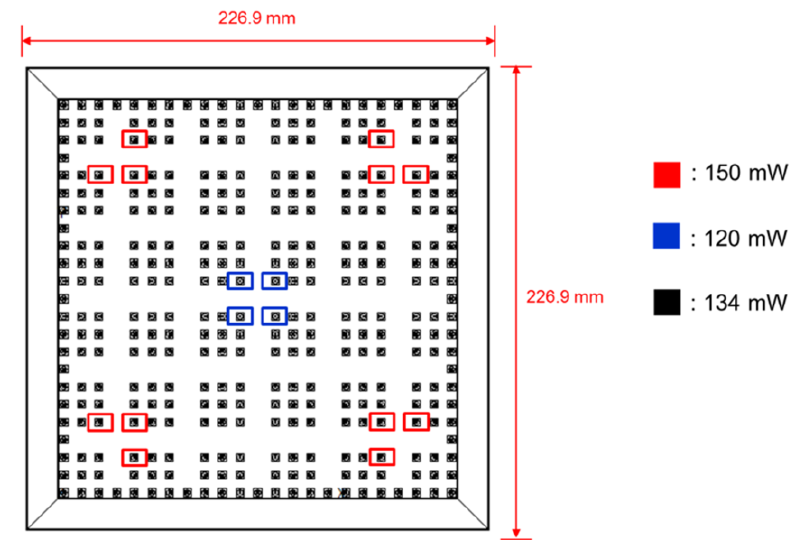
Figure 20. The LED power adjustment state .